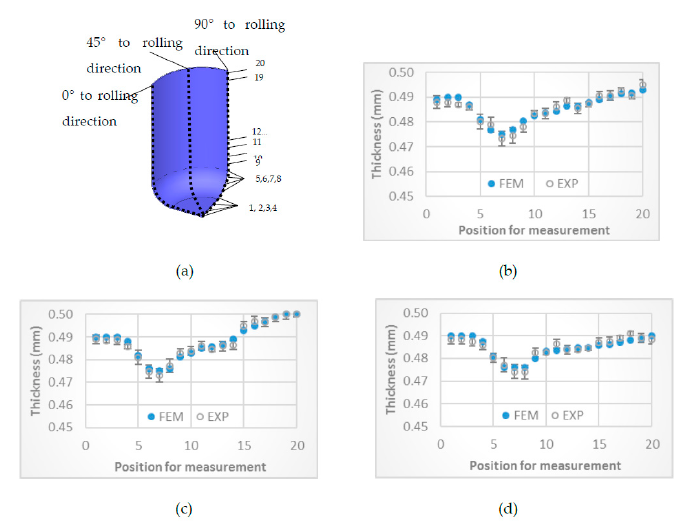
Figure 6. Cup wall thickness distribution between FEM simulation and experimental results: ( a ) Position for measurement; ( b ) 0° to rolling direction; ( c ) 45° to rolling direction; ( d ) 90° to rolling direction.